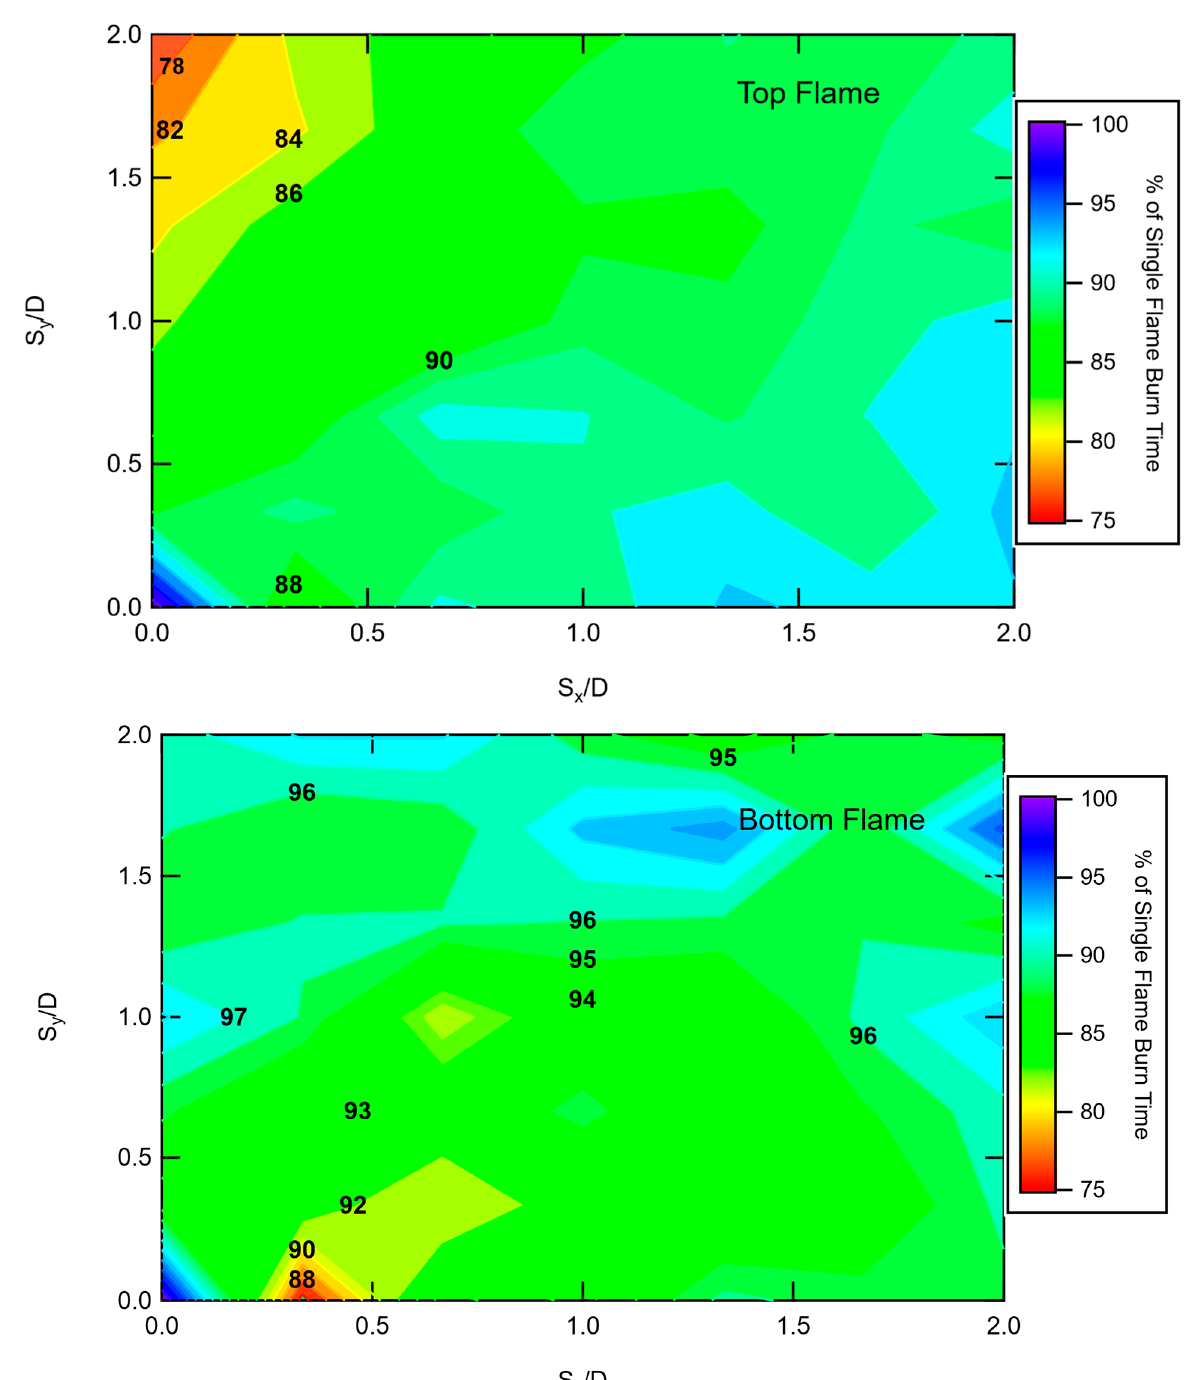
Figure 17. Flame duration times for the top and bottom flames in the two-pad experiments, normalized by the flame duration time for the single-pad experiment.